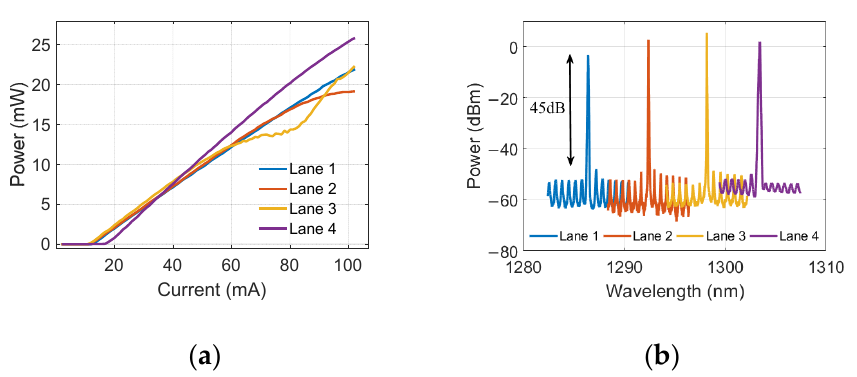
Figure 4. ( a ) Fiber coupled output power as a function of injection currents (L-I) of the LC-DFB laser array with the operating temperature at 10 °C. ( b ) The lasing spectra under injection currents of 100 mA at 10 °C.